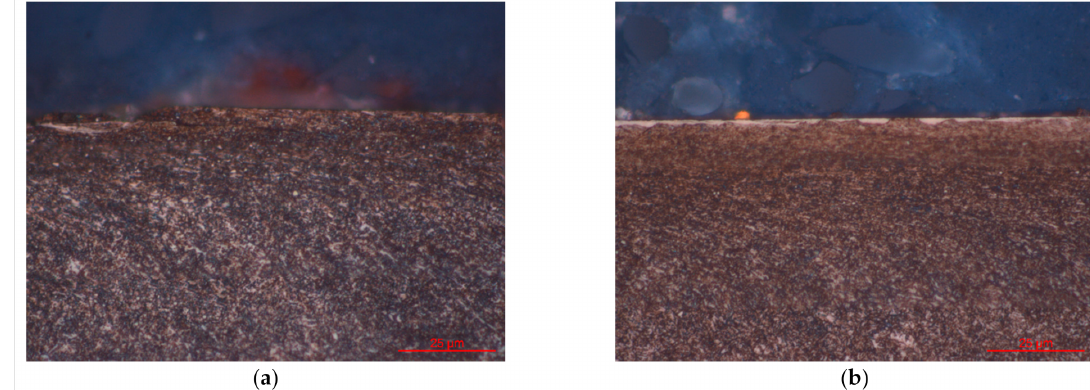
Figure 11. Optical observations on the cross-section of: ( a ) 343 ◦ C austempered disks, ( b ) 585 ◦ C quenched-tempered